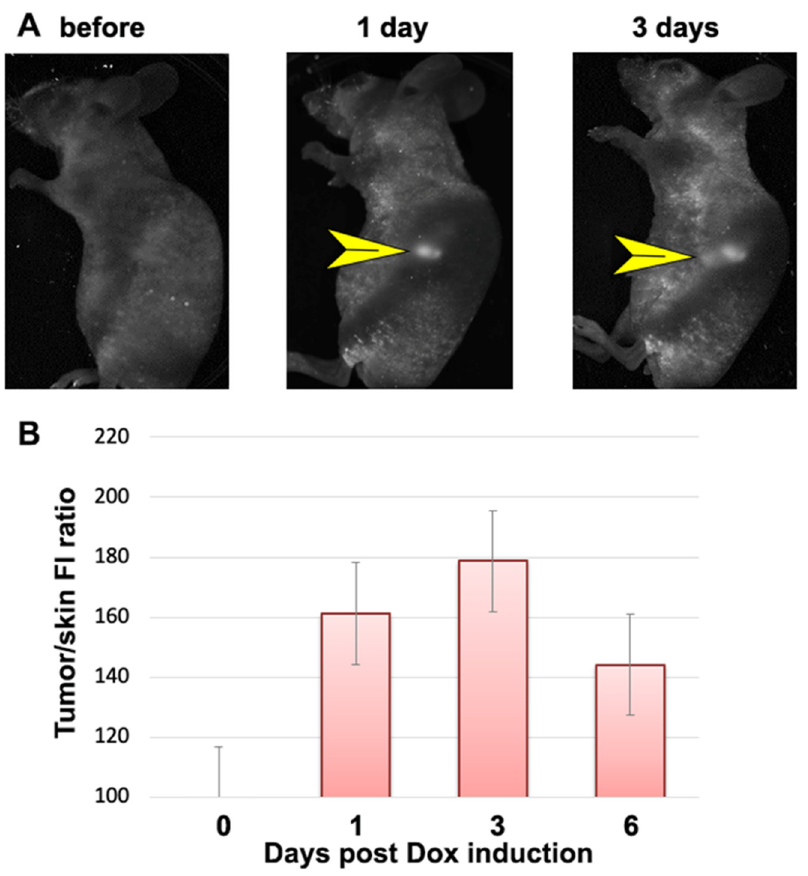
Figure 3. Tet-On Dox-induced fluorescence of dual dCas9 chimeras expressed in E9-derived tumor xenograft (A549-StdCas9-EGFP-Nm/dCas9-mCherry) after two doses of 200 µg of Dox/animal: ( A ) In vivo FI images after the induction of Nm dCas9-mCherry chimera expression before Dox induction (day 0) and on the 1st and 3rd day after Dox induction. Yellow arrowheads point to the fluorescent tumor; ( B ) Normalized red FI measured in E9 tumor xenograft after the induction of ex- pression of chimeras before induction (day 0) and 1–6 d post-Dox-induction. Excitation: 502–547 nm, emission: 570–640 nm.